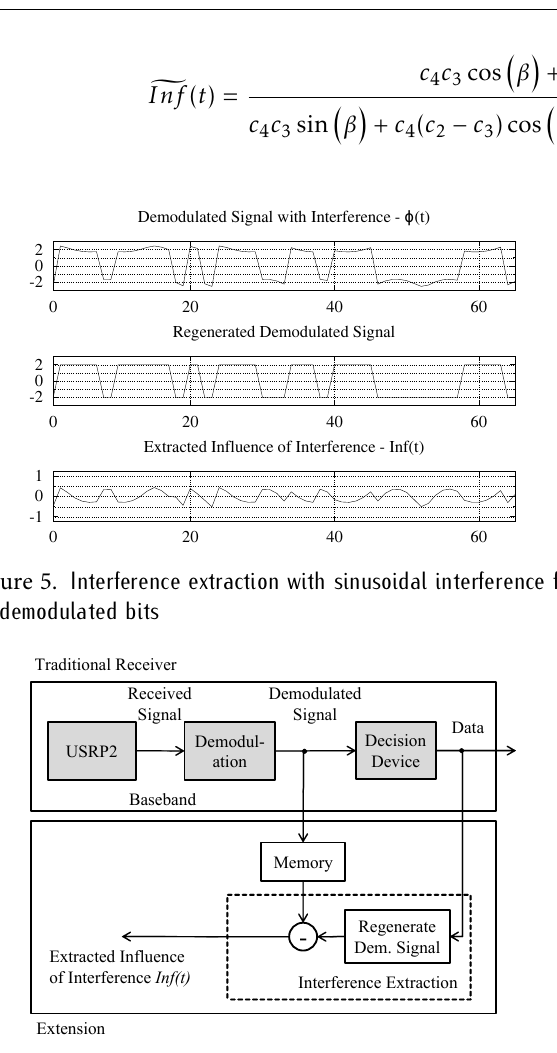
Figure 6. Extended receiver implemented with GNU Radio